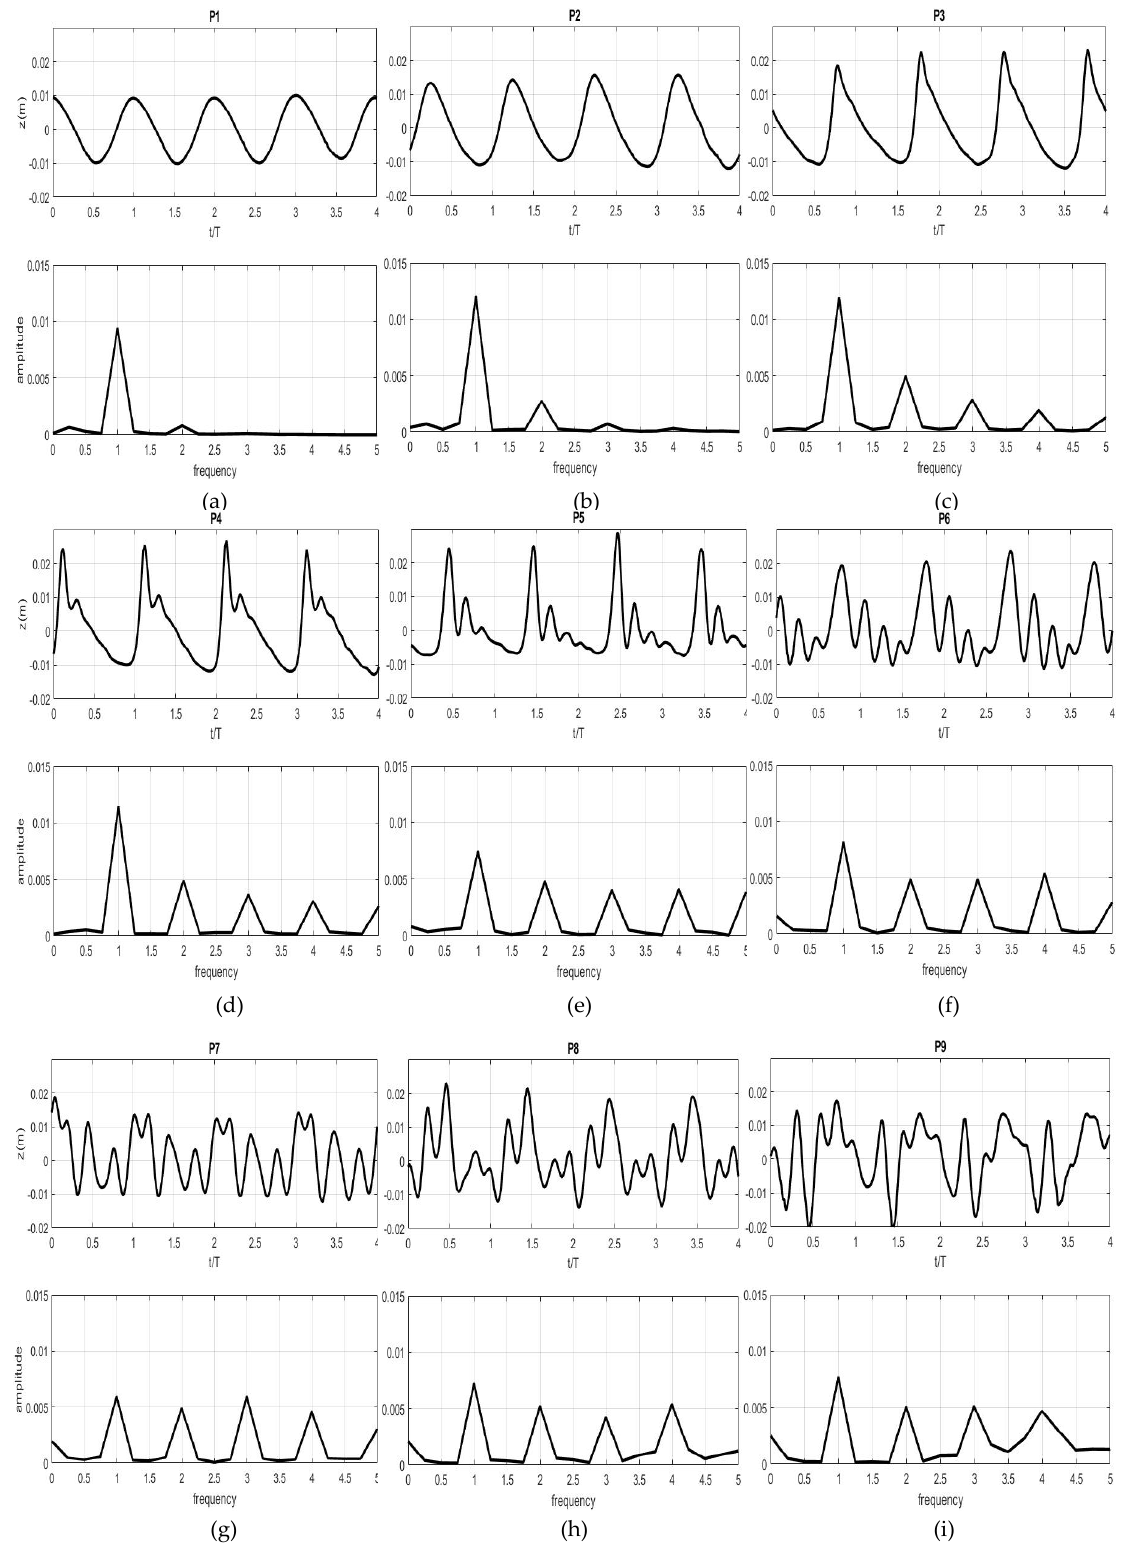
Figure 9. Simulation of surface elevations (upper) and amplitude spectra (lower) at nine positions with the incident wave height H i = 0.02 m and period T = 3.03 s passing over the trapezoidal submerged structure. Explanations of ( a-i ) are given in the caption of figure 7.